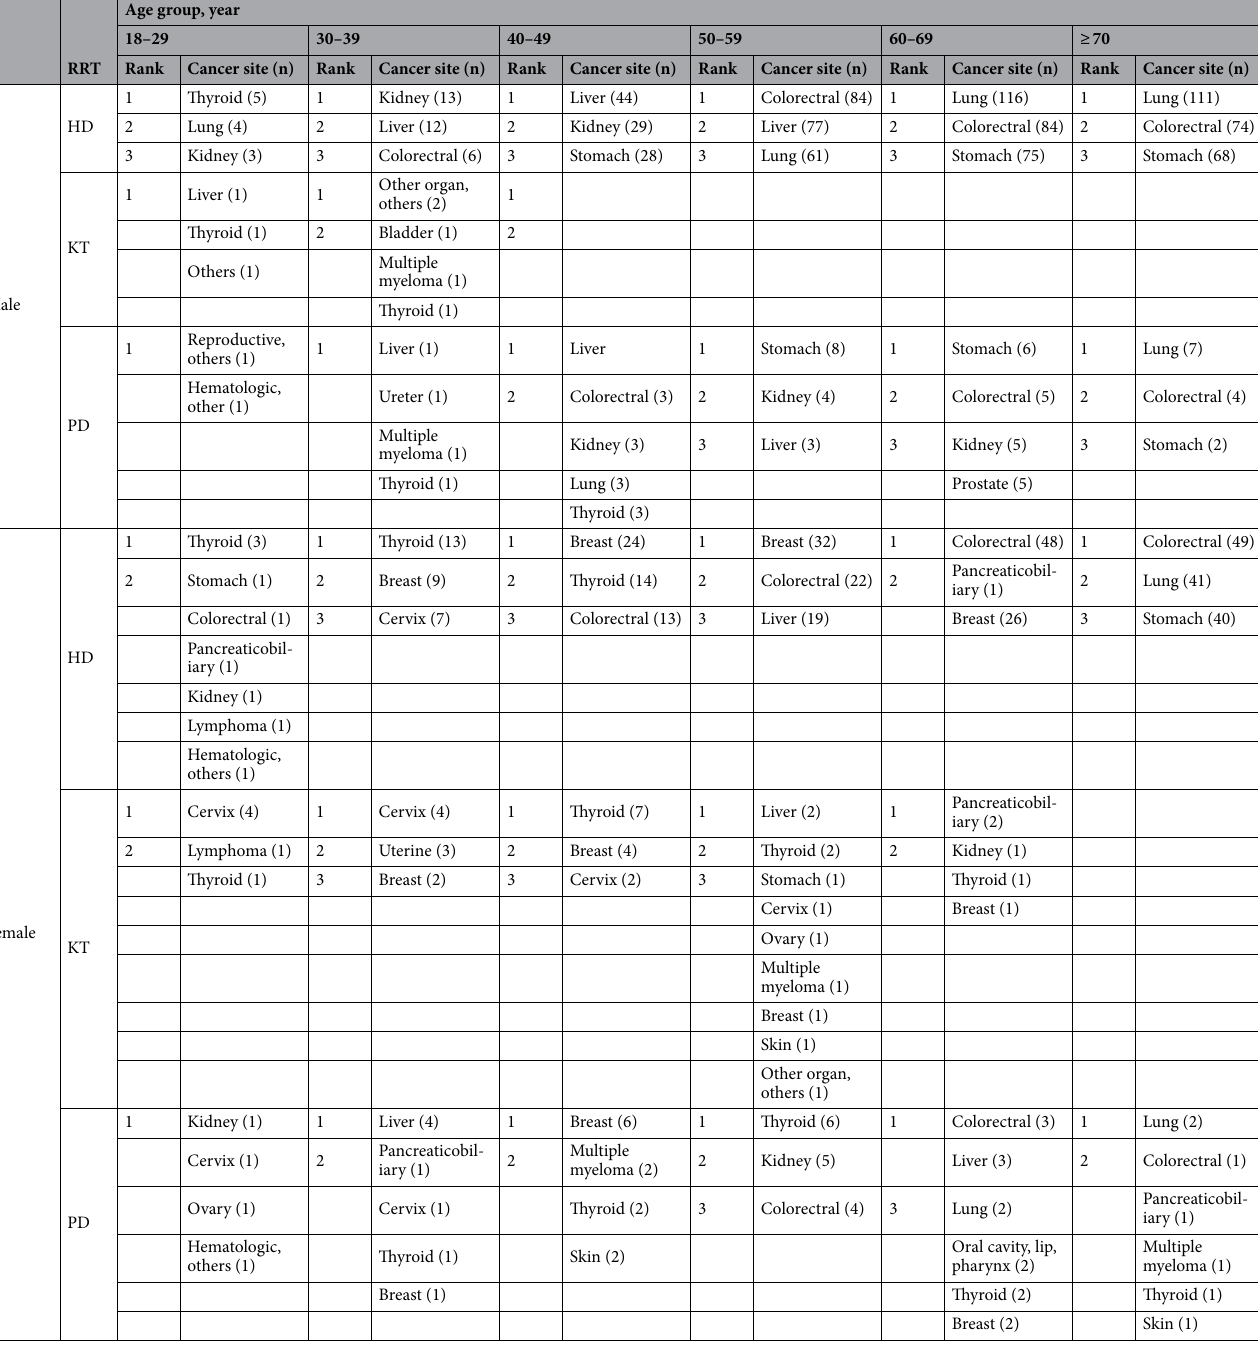
Table 3. The three most common sites of cancer incidence by age group and sex. RRT, renal replacement therapy; HD, hemodialysis; PD, peritoneal dialysis; KT, kidney